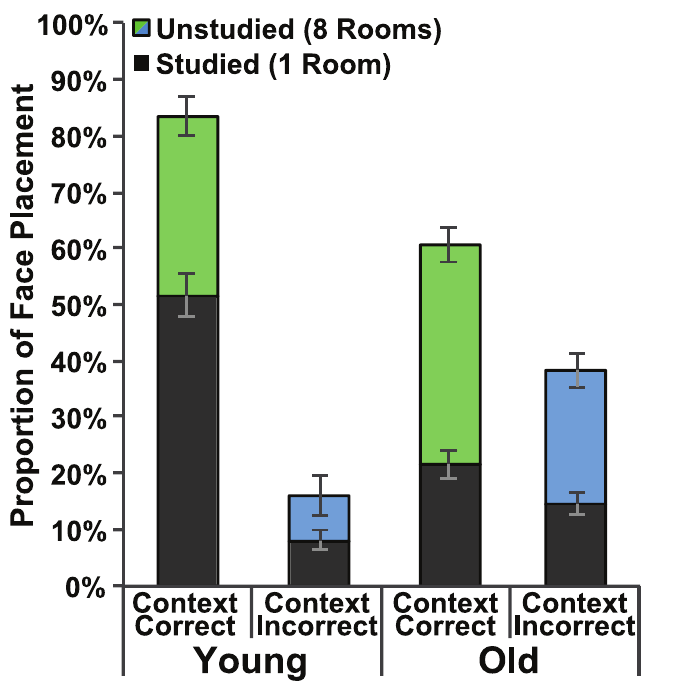
Fig 5. Behavioral performance. Proportion of face placement to rooms on the correct (green) and incorrect (blue) side of the building. Dark bars indicate face placements to the studied room on a given side whereas colored (green or blue) bars indicate face placements to any of the remaining eight unstudied rooms. Data are presented for both the Young Adult and Older Adult groups and standard error bars are